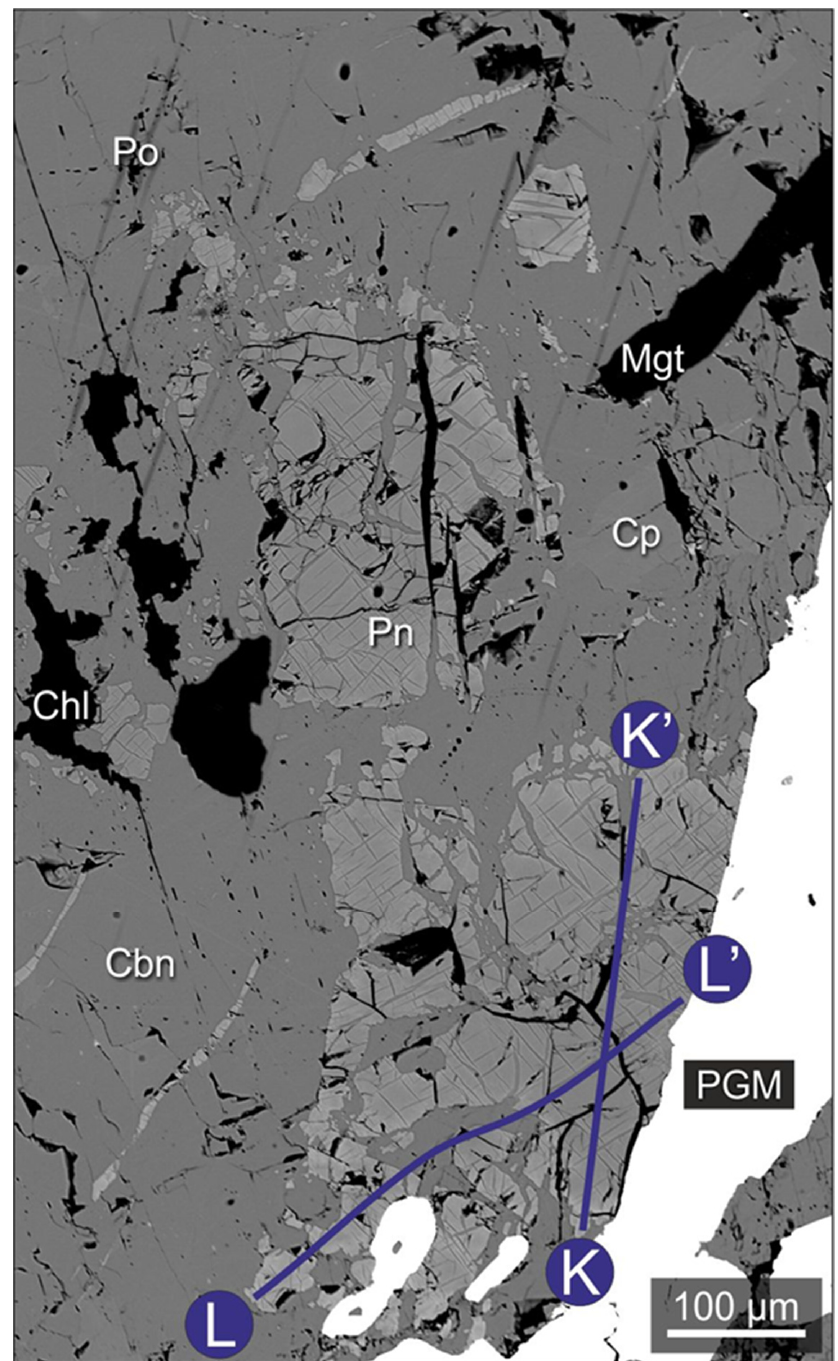
Figure 7. BSE image of cubanite ore in the sample 32 − 11, depth 76.5 m, used for EDS mapping (Figure 8). Lines KK’ and LL’ show microprobe profiles through the large crystal of Pd-rich pentlandite (Figure 9). Abbreviations: Cbn—cubanite; Chl—chlorite; Cp—chalcopyrite; Mgt—magnetite; PGM—multiphase grain of platinum group minerals; Pn—pentlandite; Po—pyrrhotite.